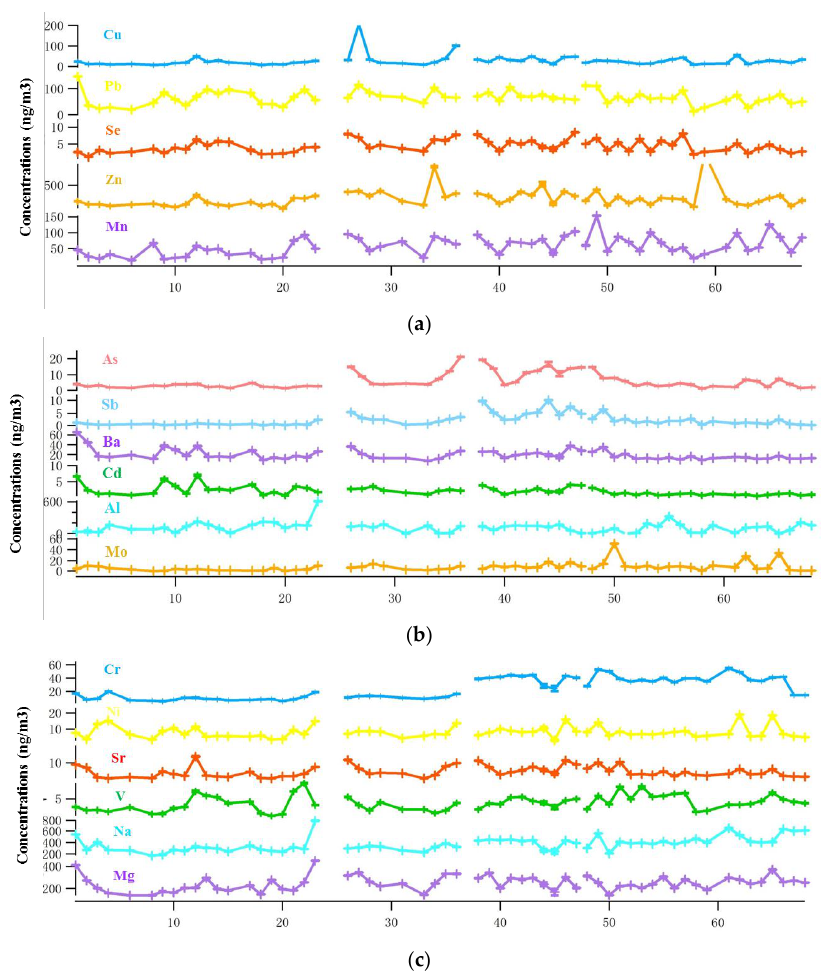
Figure 3. Temporal variations of the 17 metal elements in PM 2.5 . ( a )Time series of metal Cu, Mn, Pb, Zn, Se; ( b ) Time series of metal As. Sb, Ba, Cd, Al, Mo; ( c ) Time series of metal Cr, Ni, Sr, V, Na, Mg